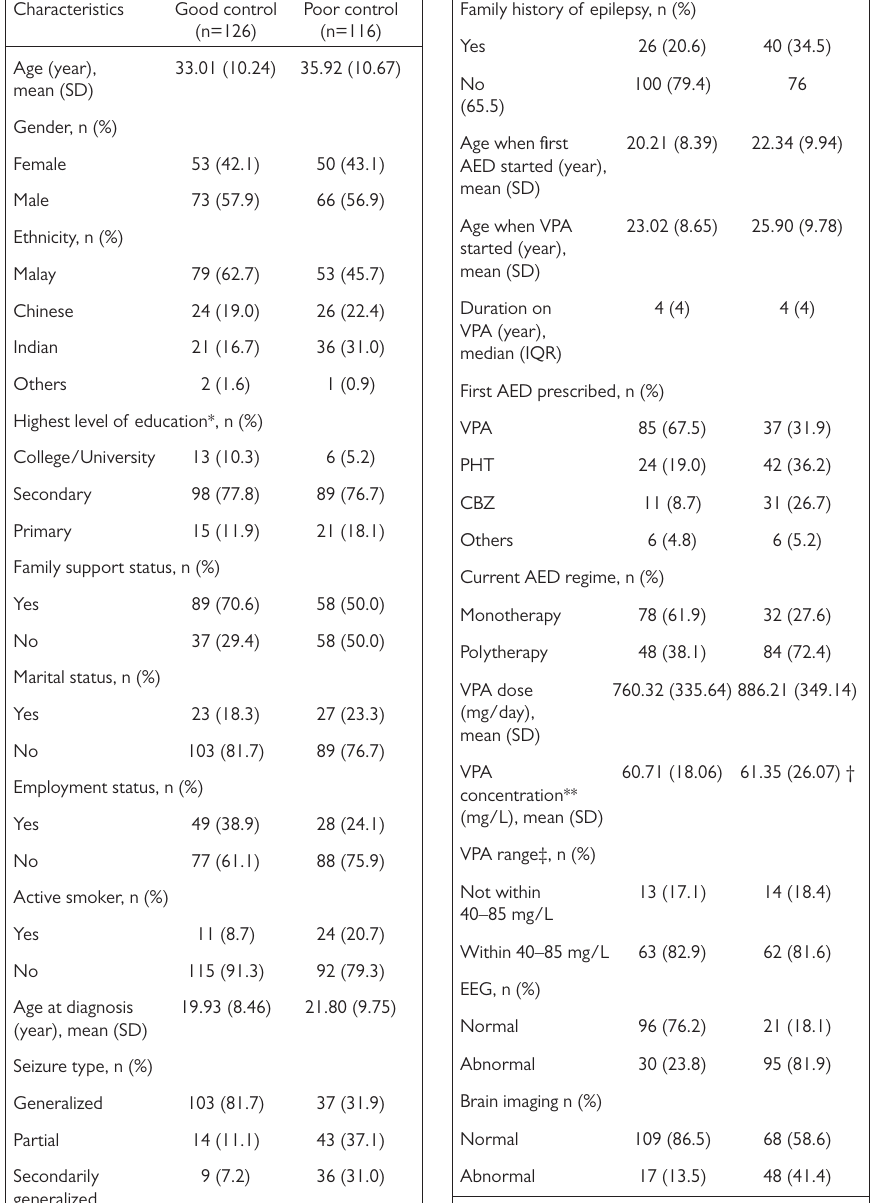
Table 1. Characteristics of patients with epilepsy on valproic acid